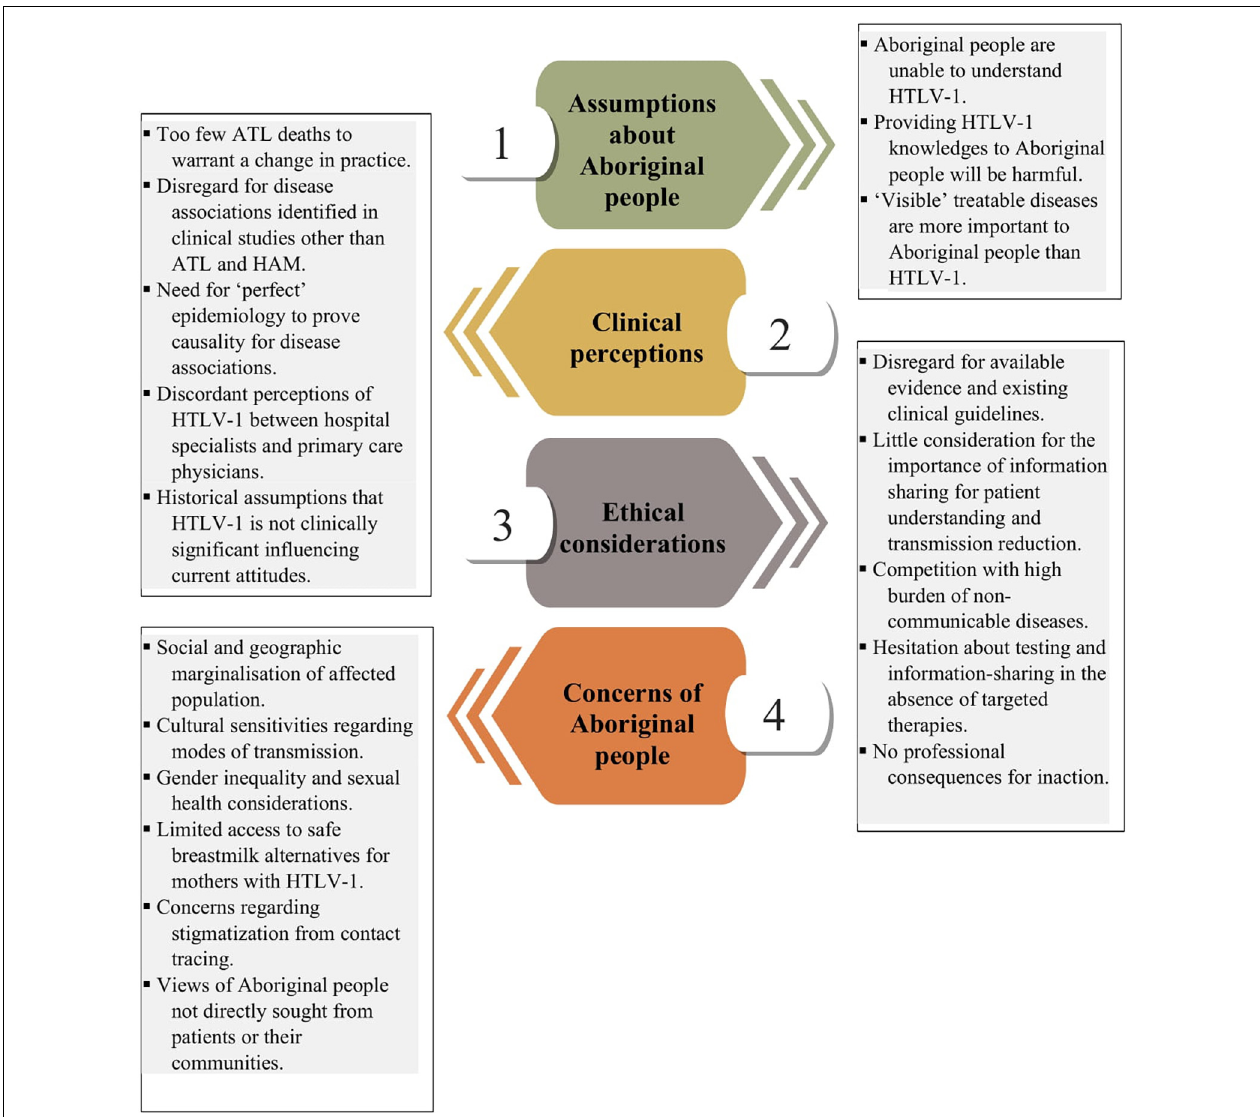
FIGURE 2 | Barriers to the prevention of HTLV-1 in Central Australia. Modified figure ©